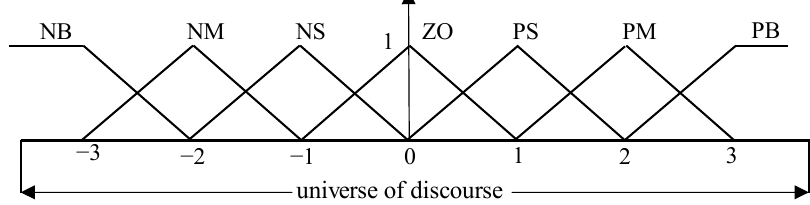
Figure 4. The input trigonometric membership functions of the fuzzy-PID controller.